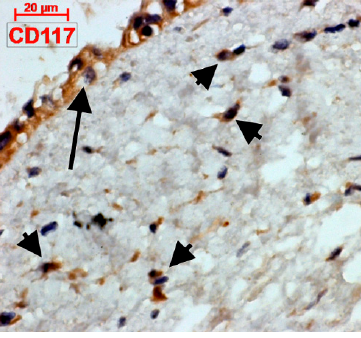
Figure 3. Human adult cardiac wall. CD117/c-kit has epicardial (mesothelial) (arrow) and subepicardial (arrowheads) expression. Appl. Sci. 2019 , 9 , x FOR PEER REVIEW